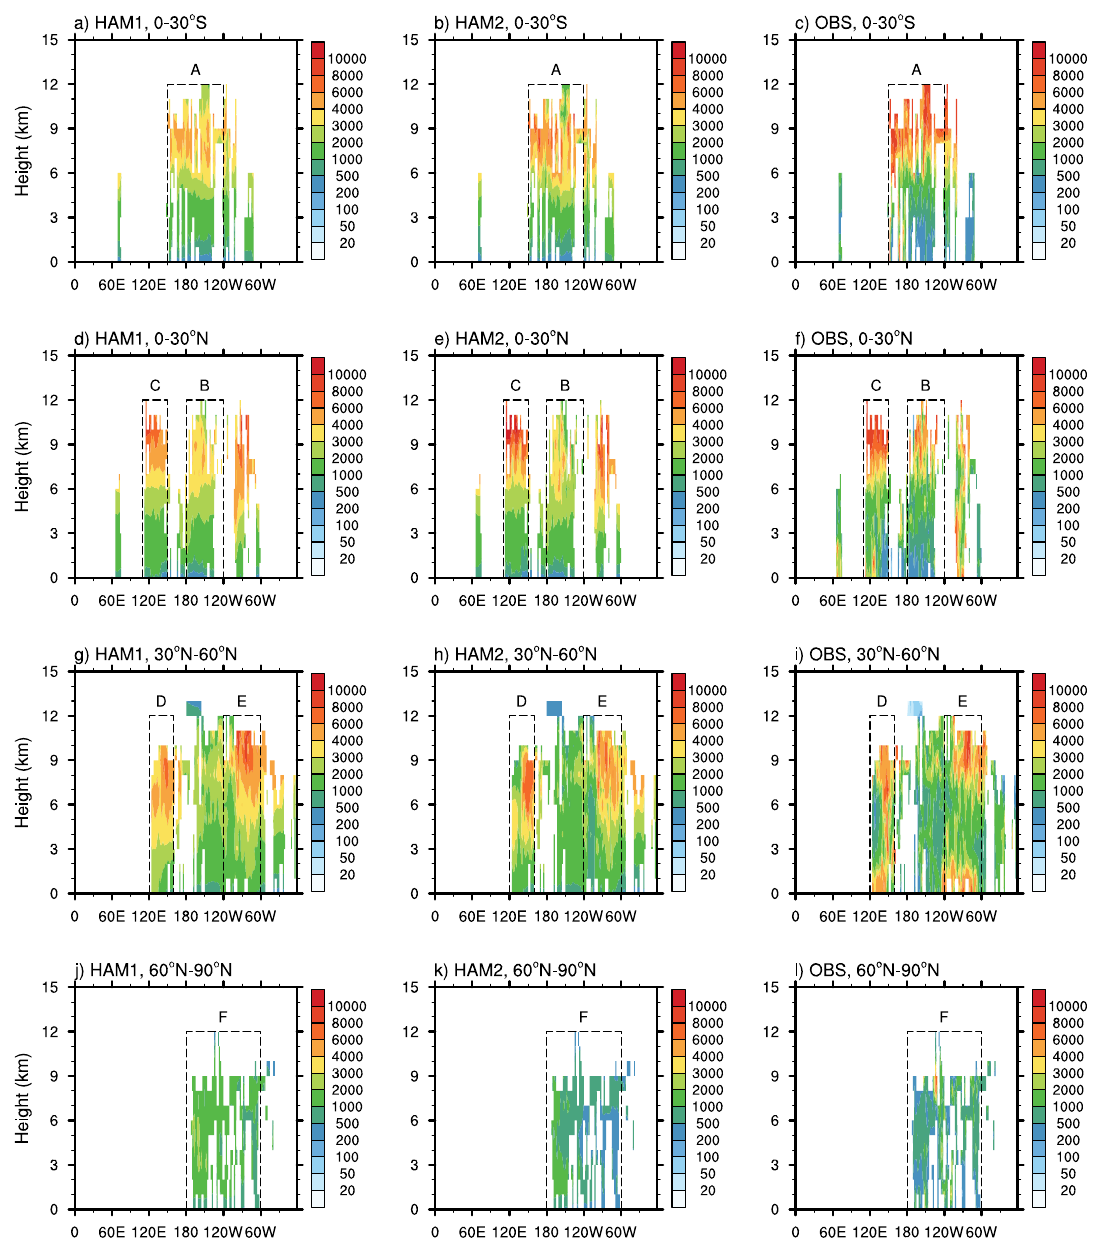
Fig. 11. Vertical distribution of simulated and observed condensation nuclei concentrations (unit: cm − 3 STP) in different regions. The observational data are compiled from campaign measurements shown in Fig. 10 and Table A1. Model results are derived from daily mean output of the months in which the measurements were obtained. The simulated CN concentrations are derived by integrating over the aerosol size distributions. The lower cut-off value of particle dry diameter is 0.01µm. Dashed boxes indicate regions in which the vertical profiles are compared in Fig.